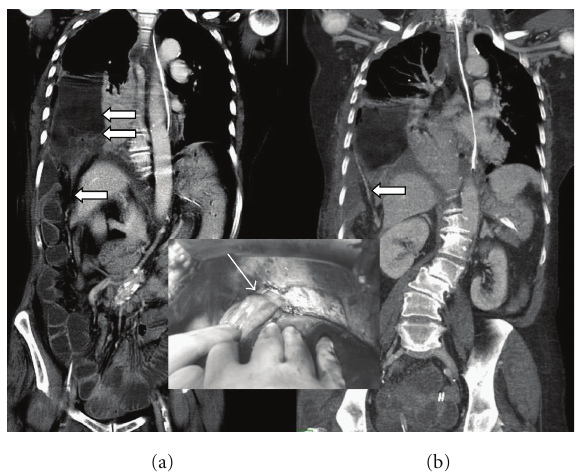
Figure 2: Multidetector CT performed after contrast medium injection and reformation in the frontal plane (a) revealed a large defect in the right diaphragm with herniation of the right colon (straight arrow). Fluid present above the right diaphragm is explained by the distension and perforation of the caecum (double arrows). Note the dilatation of the small bowel loops in relationship with incarceration of the caecum through the diaphragm defect. Maximalintensity projection (MIP) performed on a posterior plane (b) revealed the migration of the right colonic artery (straight arrow) with the ascension of the right colon. Inset: intraoperative view of the right colon herniated through the Bochdalek hernia